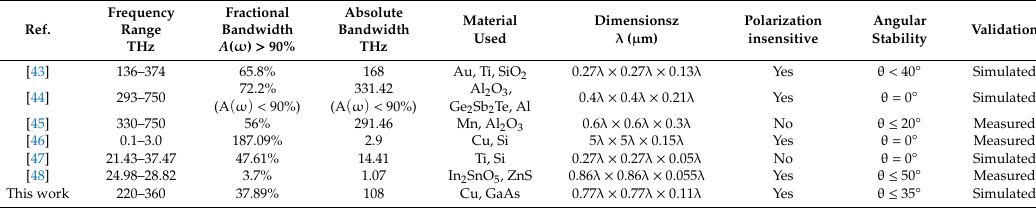
Table 2. Comparison with recent studies of ultra-wideband absorbers.